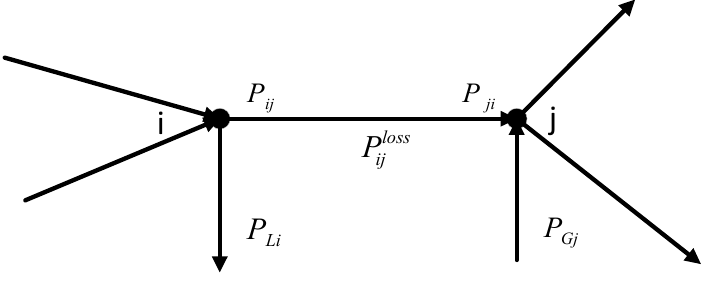
Figure 3. Branch power and loss.